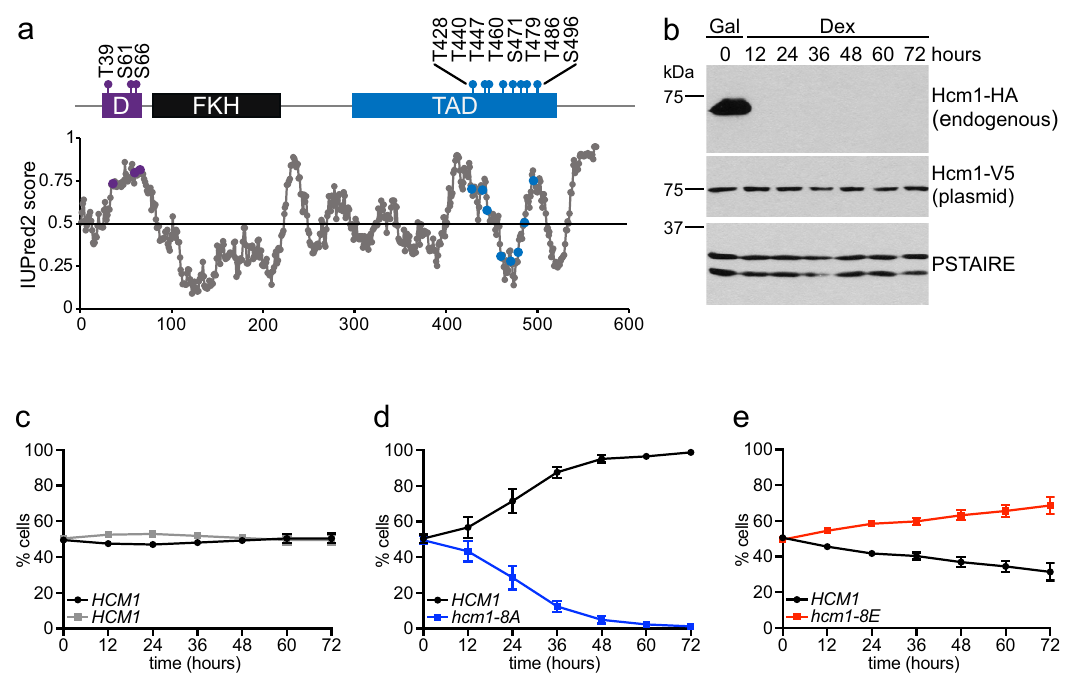
Fig.1|PhosphorylationoftheHcm1TADregulates fi tness.a Schematicshowing previously characterized CDK consensus sites (S/T-P), domains and predicted dis- ordered regions. D phosphodegron, FKH forkhead domain, TAD transactivation domain. IUPred2 disorder prediction shown with phosphorylation sites in purple (D)andblue(TAD). b Westernblotshowingexpressionoftheindicatedproteinsat the timepoints shown. Strains were initially grown in galactose (Gal) to allow expression of the 3HA-tagged WT protein from the genome and were shifted to dextrose (Dex) to repress WT expression at the start of the experiment. Plasmid- expressed Hcm1 proteins were detected with an antibody that recognizes a